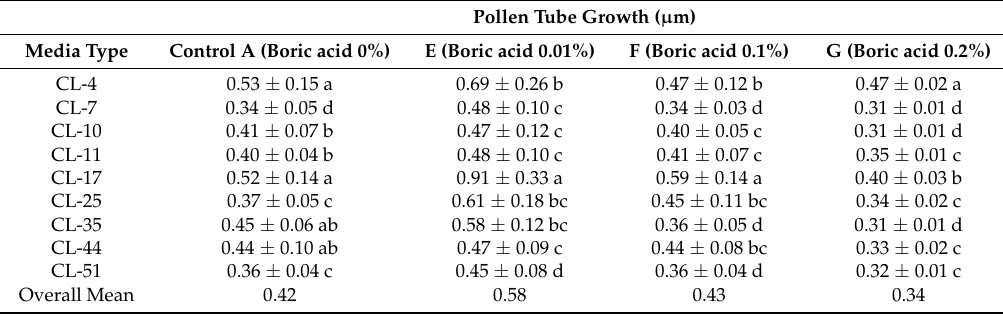
Table 5. Effects of boric acid concentration on pollen tube growth.